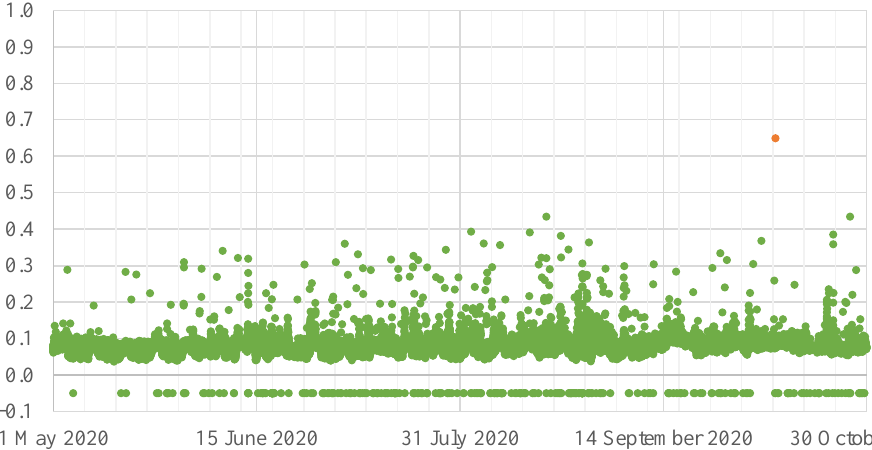
Energies 2020 , 13 , x FOR PEER REVIEW Figure 3. Global power quality index changeability for MV_HPP&EES. Figure 3. Global power quality index changeability for MV_HPP&EES. Figure 3. Global power quality index changeability for MV_HPP&EES.